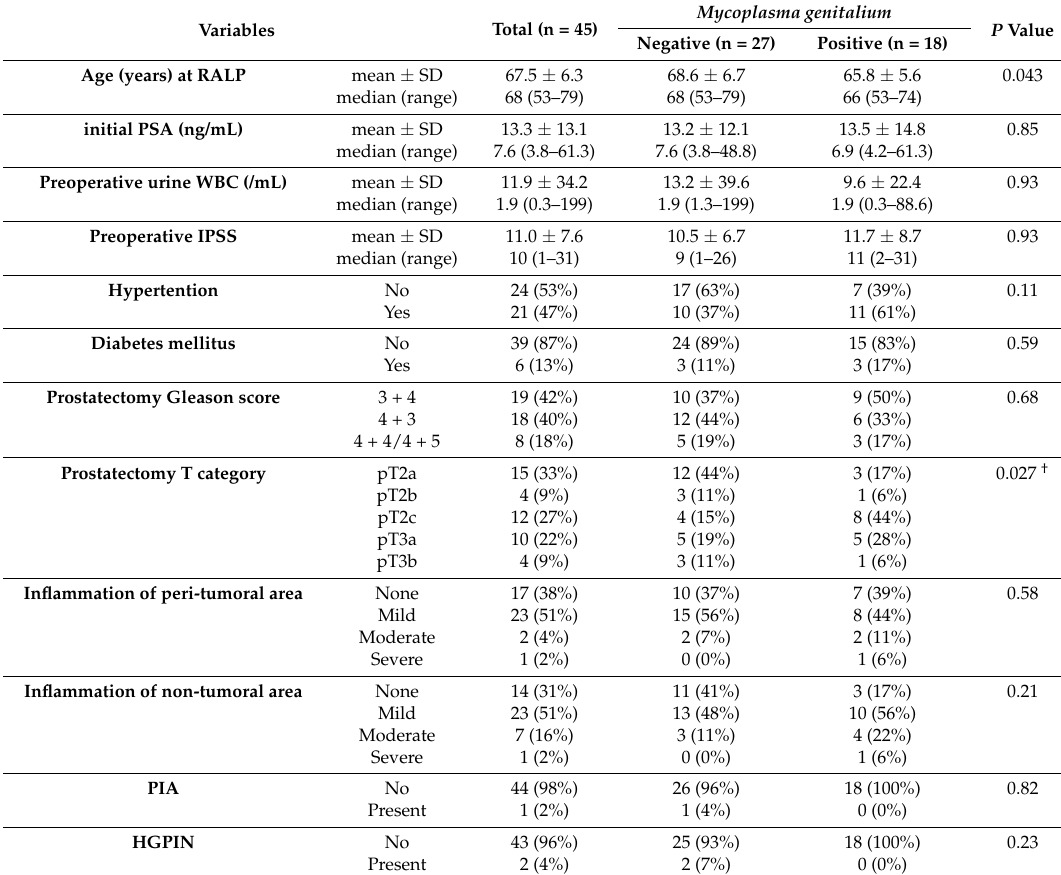
Table 3. Clinicopathological variables of the 45 patients with PCa and the statistical comparison by Mycoplasma genitalium infection status in prostate surgical